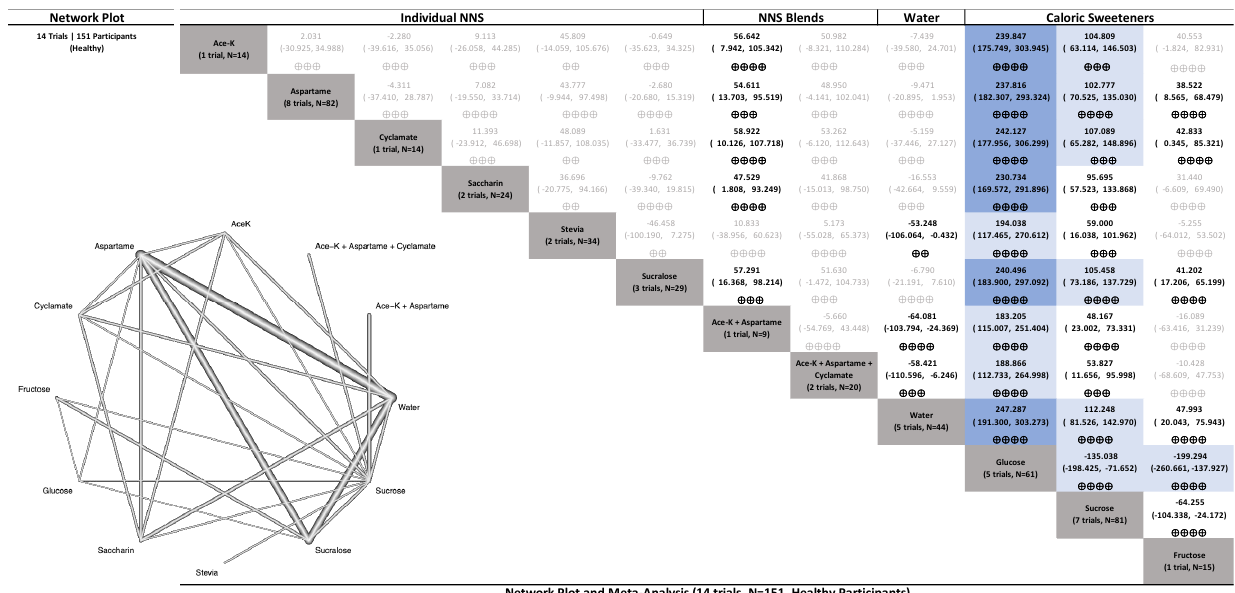
N e t w o r k P l o t